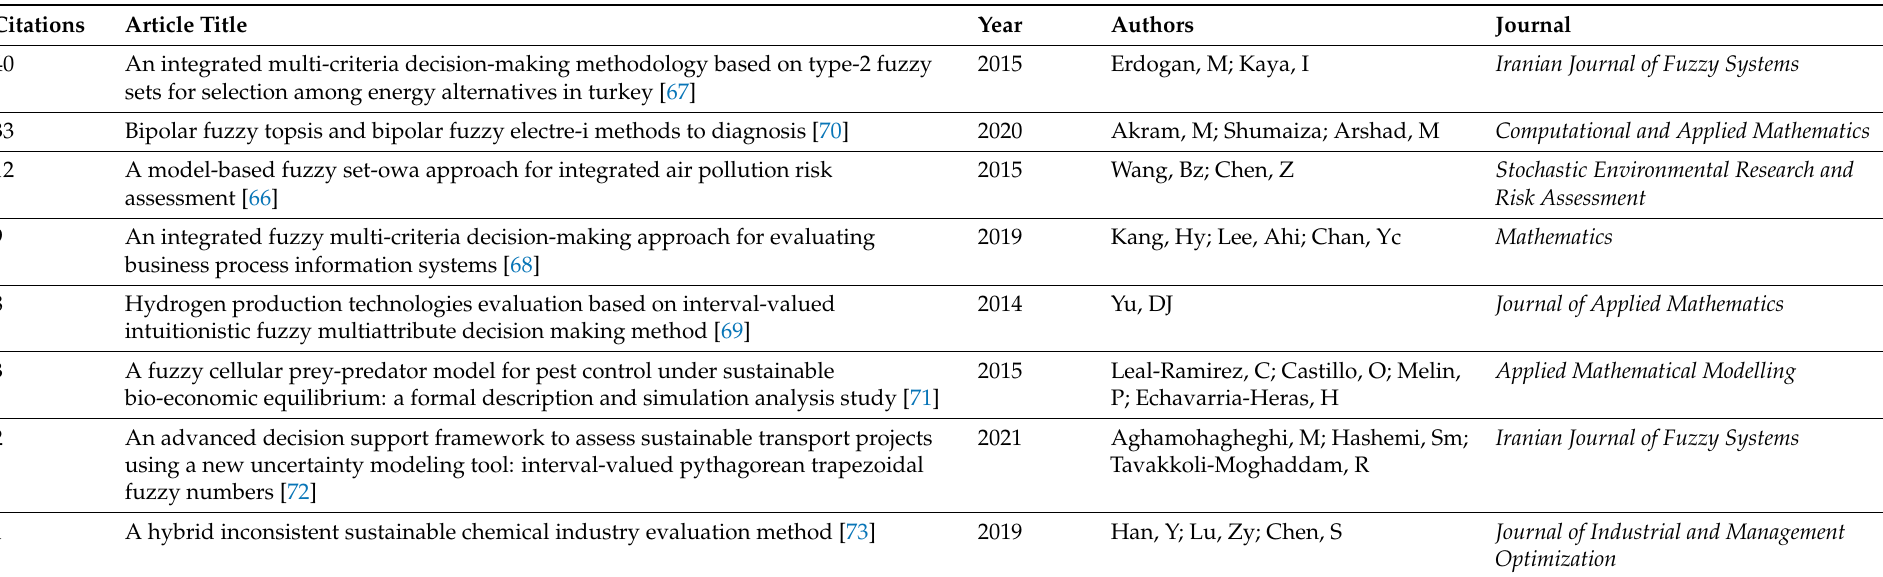
Table A2. Higher-impact articles for a scope restricted to sustainability and research